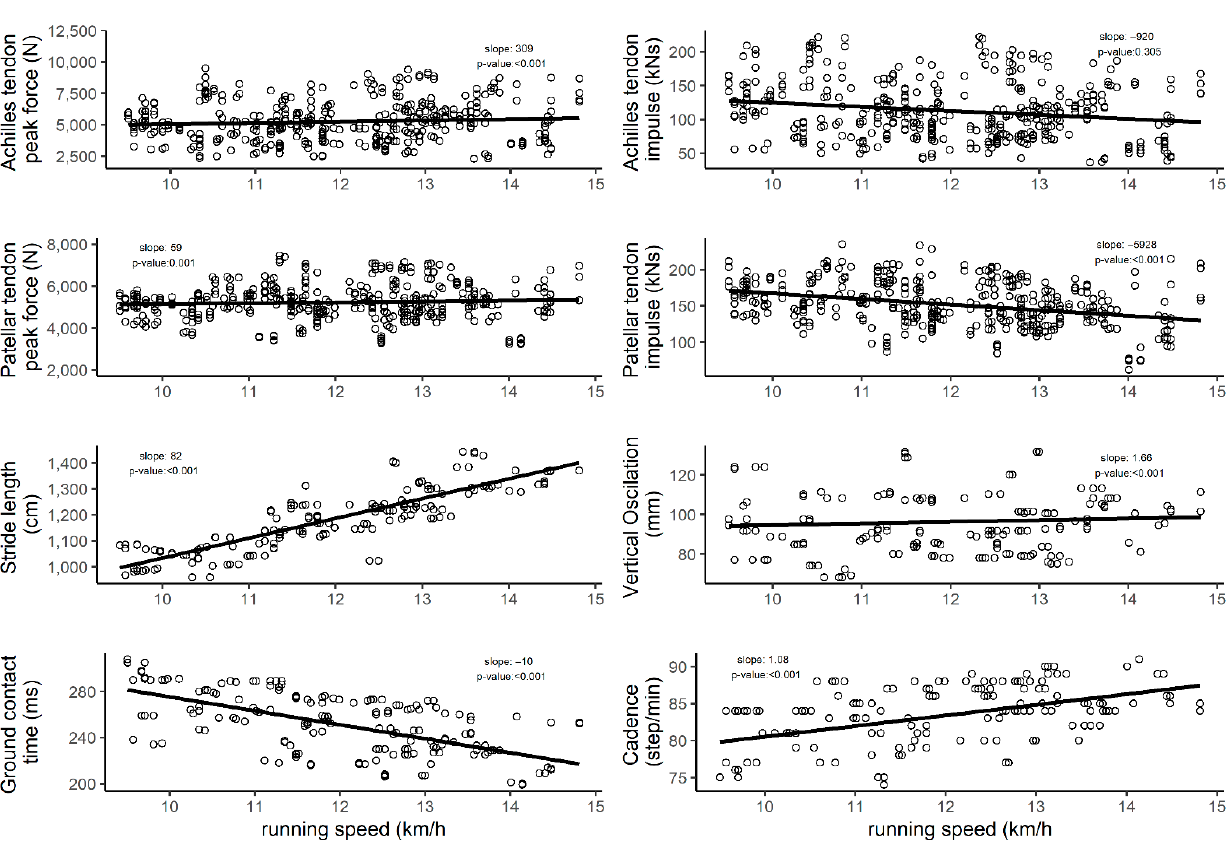
Figure 2. The association between running speed and step-specific tendon force, impulse per stride, stride length, vertical oscillation, ground contact time, and cadence.